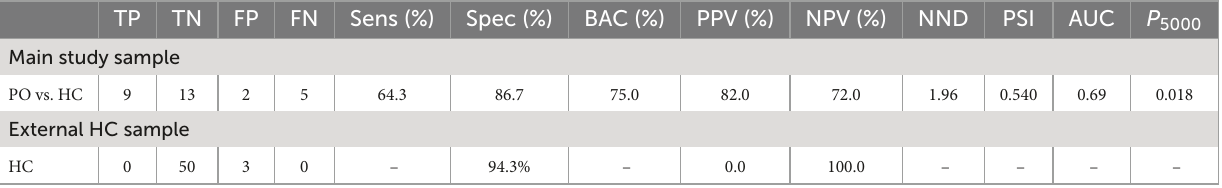
TABLE 2 Prediction performance in the main study and external HC sample.